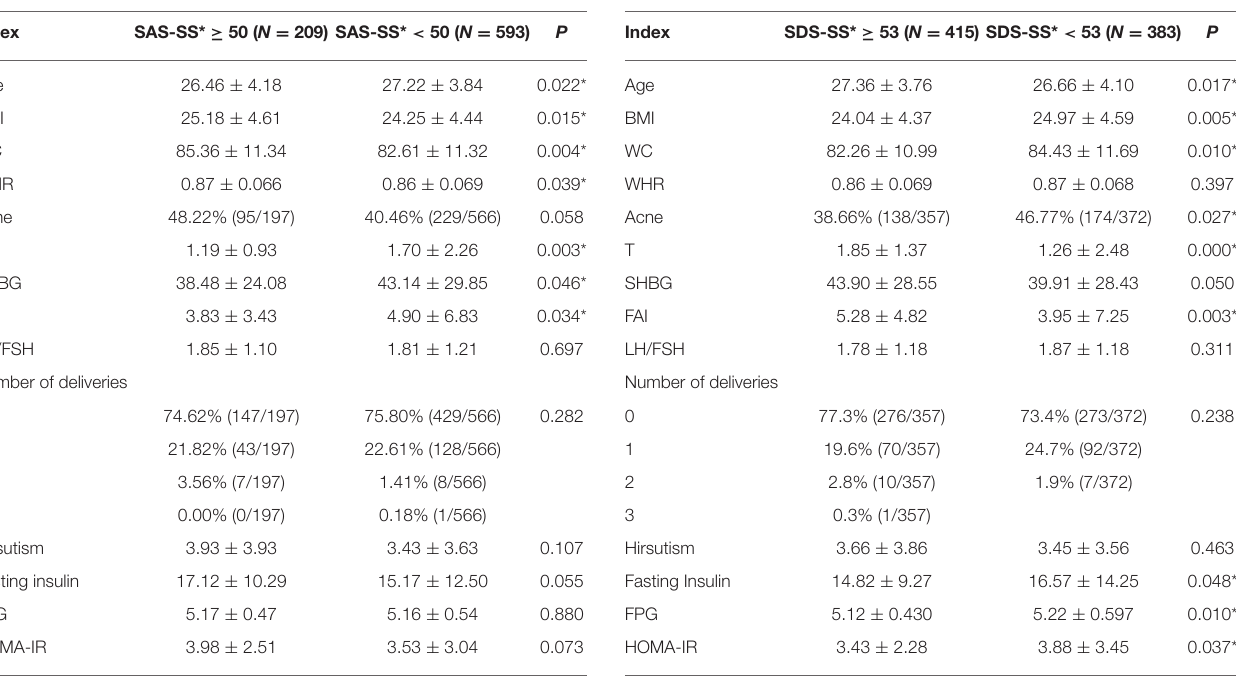
TABLE 2 | Baseline characteristics of women with PCOS with depression (SDS-SS ≥ 53) and without depression (SDS-SS <